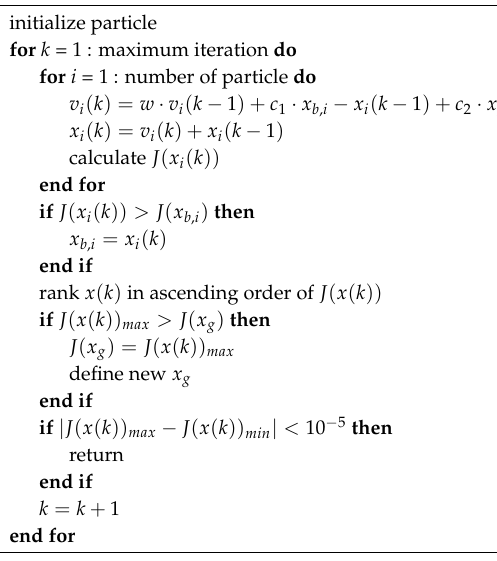
Algorithm 1 Pseudocode for the PSO algorithm